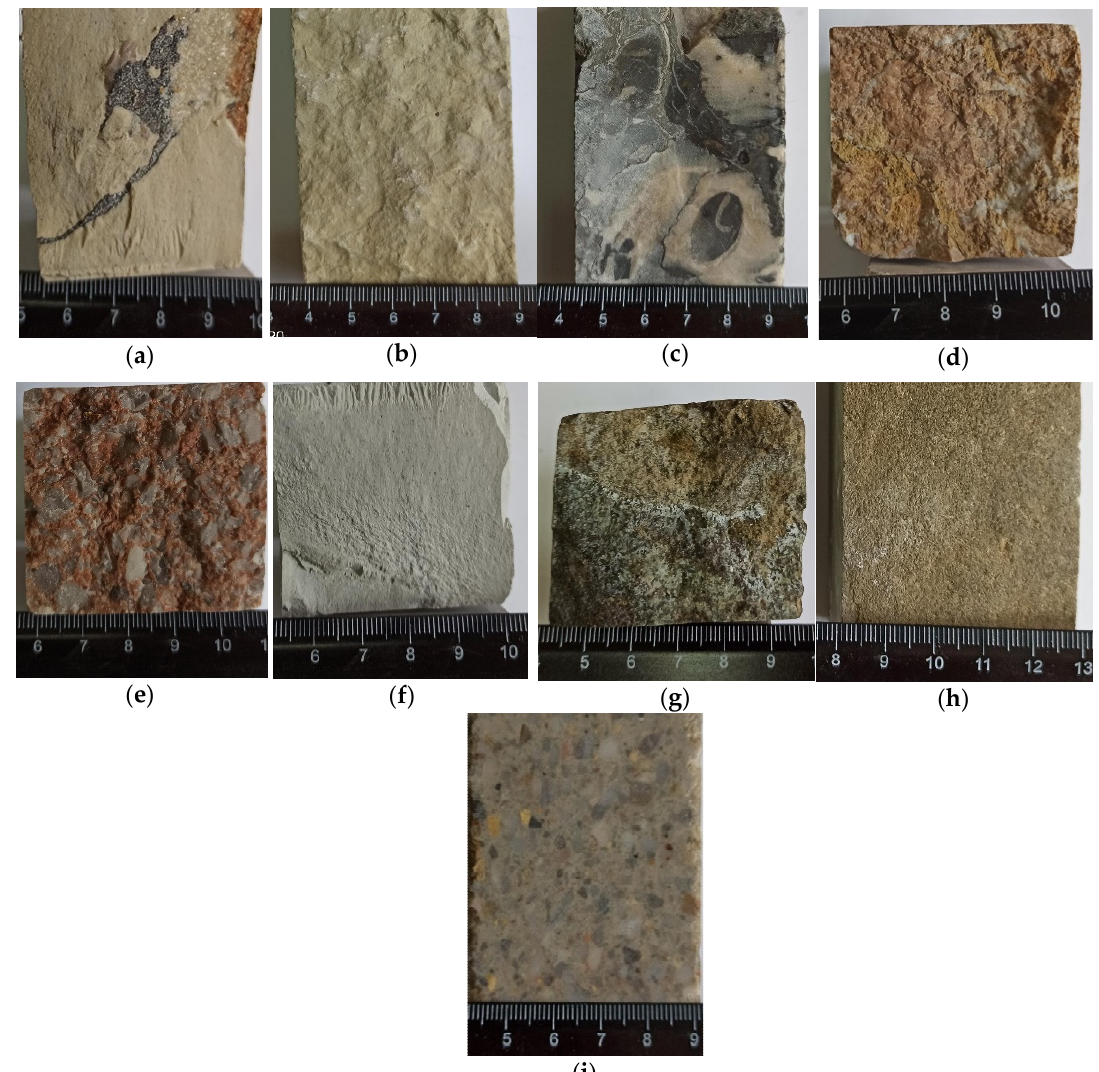
Figure 7. Thin bedded limestone: ( a ) micritic, ( b ) medium-grained, ( c ) limestones with rudist, ( d ) macro-grained; ( e ) conglobreccias and breccias; ( f ) dolomites ( g ) marl; ( h ) sandstones, ( i ) breccies [units: cm].